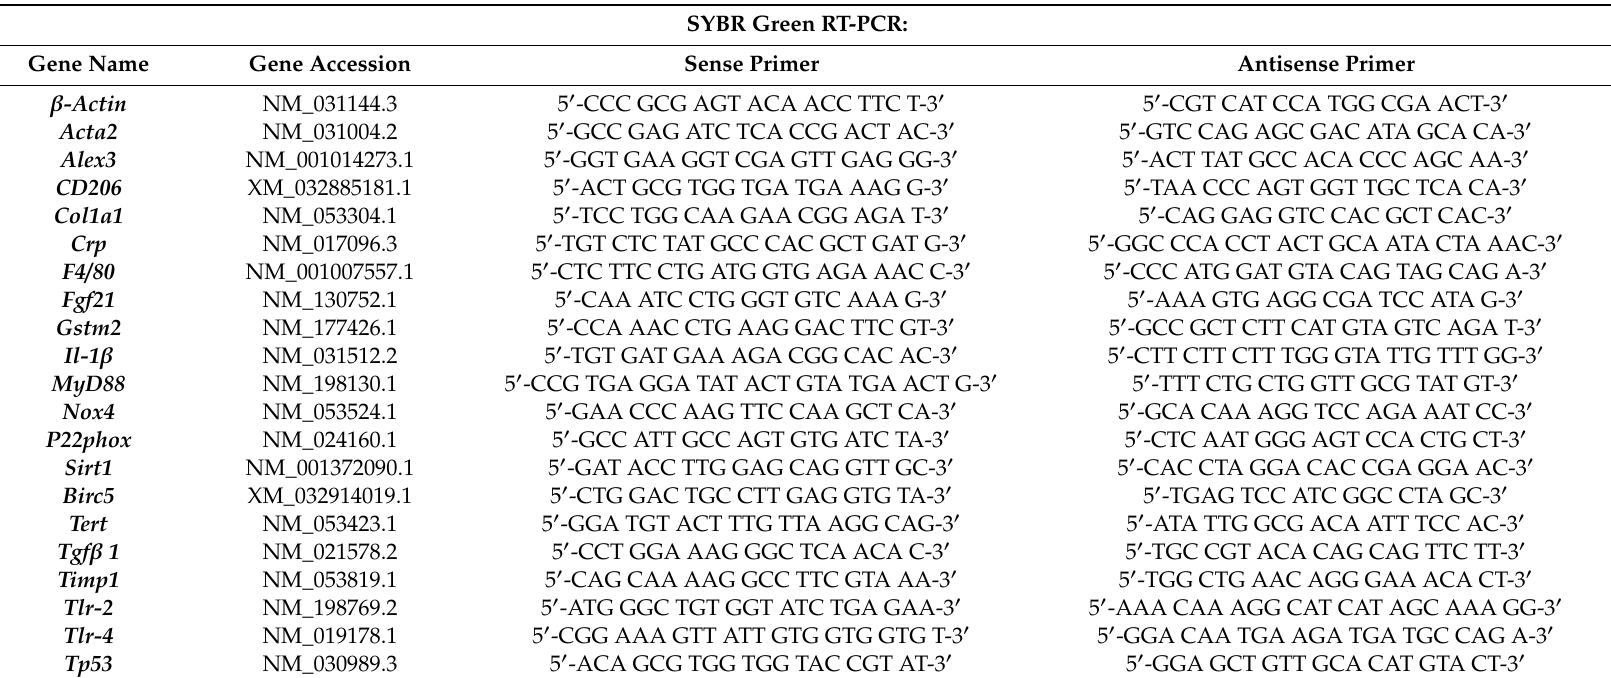
Table 1. Primer sequences for quantitative Real-Time PCR amplification with SYBR Green Master Mix. SYBR Green